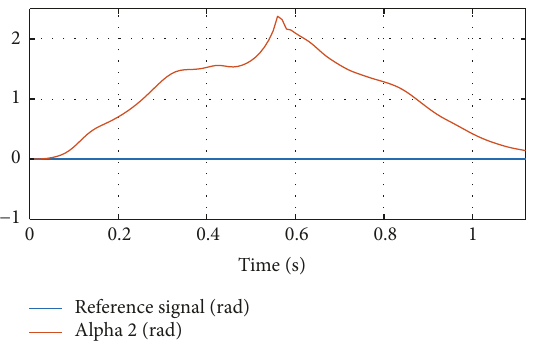
Figure 21: Trajectory of 𝛼 2